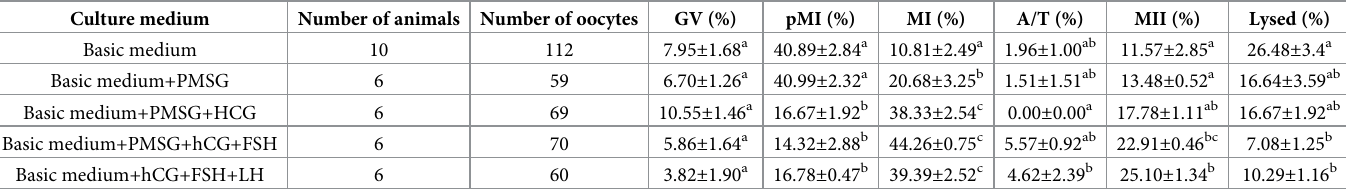
* Different superscript letters (a, b or ab) in the same column indicate statistical significance between different variables (P < 0.05). IVM rates of type A oocytes cultured under different conditions were shown. FBS, fetal bovine serum; PMSG, pregnant horse serum gonadotropin; hCG, human chorionic gonadotropin; FSH, follicle- stimulating hormone; LH, luteinizing hormone; GV: germinal vesicle; pMI: pro-metaphase I; MI: metaphase I; AI: anaphase I; TI: telophase I; MII: metaphase